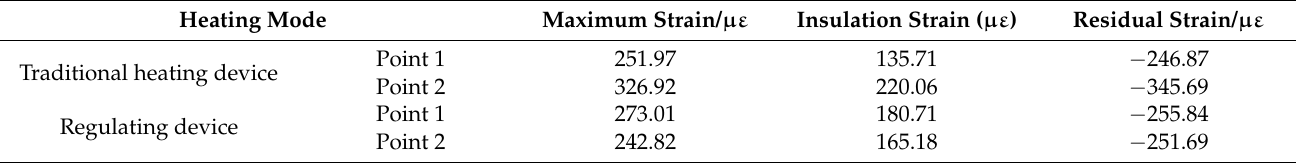
Table 4. Monitoring results with different heating